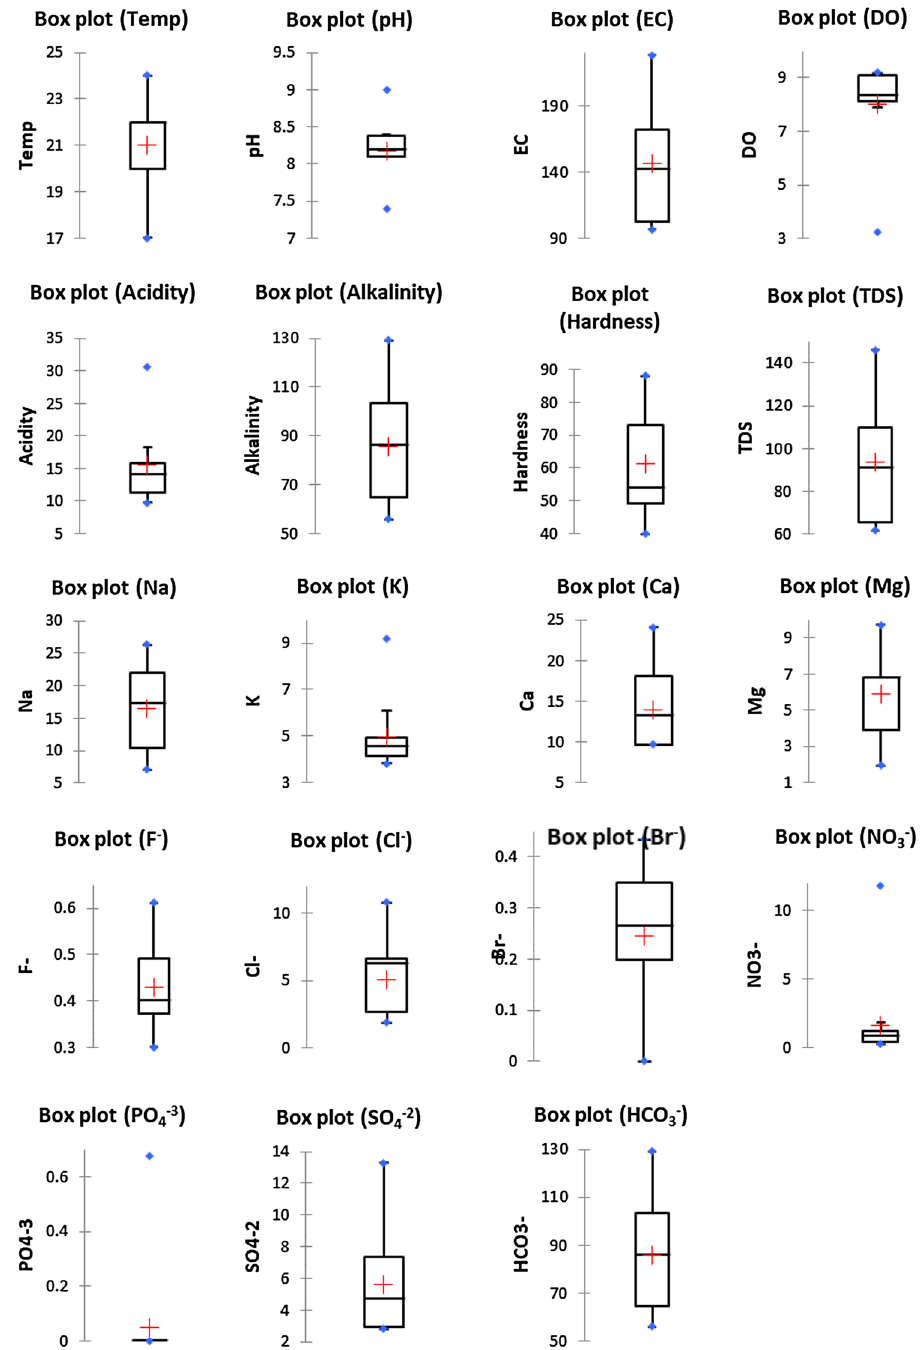
Fig. 5 Box plot of variables of post-monsoon